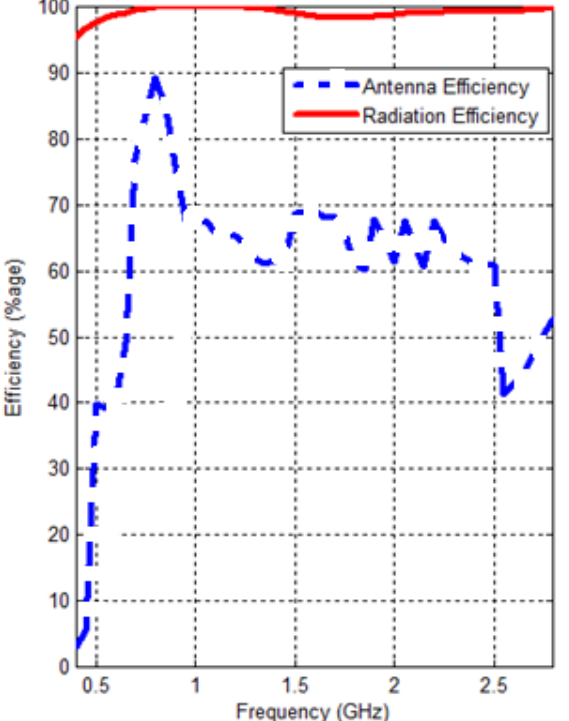
Figure 7. Simulated antenna efficiency and